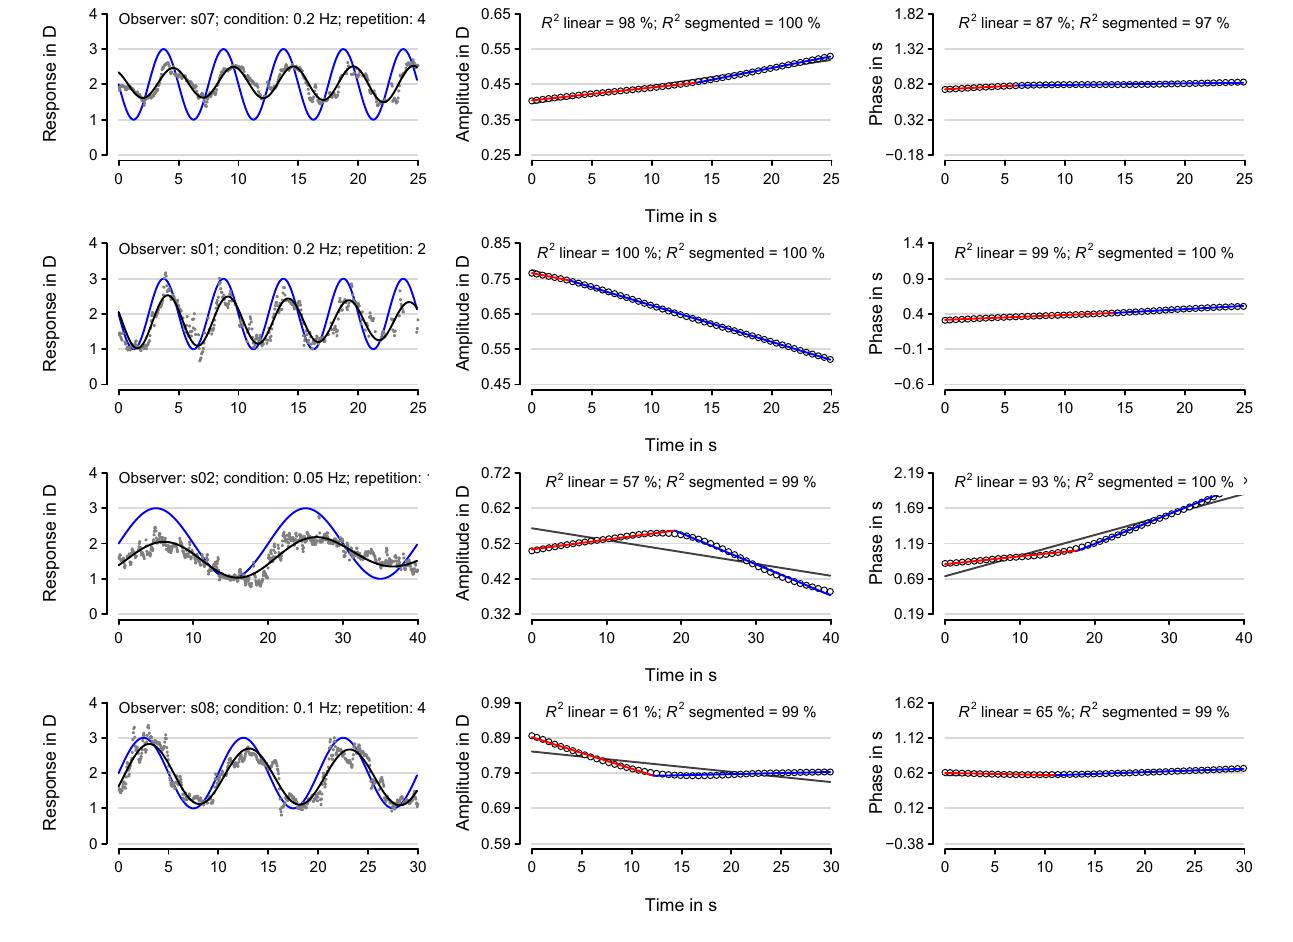
Figure 3. Sample trials for the different experimental conditions. Each row shows a single trial. The left column shows the recorded accommodative response (dark gray dots) to a sinusoidally moving stimuli (blue curve) and the local-sinusoidal fit (black curve) specified by Eq. (2). The observer, condition, and repetition number are specified on the top of each graph. The middle column shows the amplitude in D of the fit in the left column (open black circles) sampled at every 0.5 s. The right column shows the same as the middle column but for phase in s. Simple linear regression fits of amplitude and phase over time in the middle and right columns are shown in dark gray. First and second segments fitted using a broken-stick model are shown in red and blue, respectively. The dark gray line in some of the fits are not visible because they are masked by the red and blue lines fitted by the broken-stick